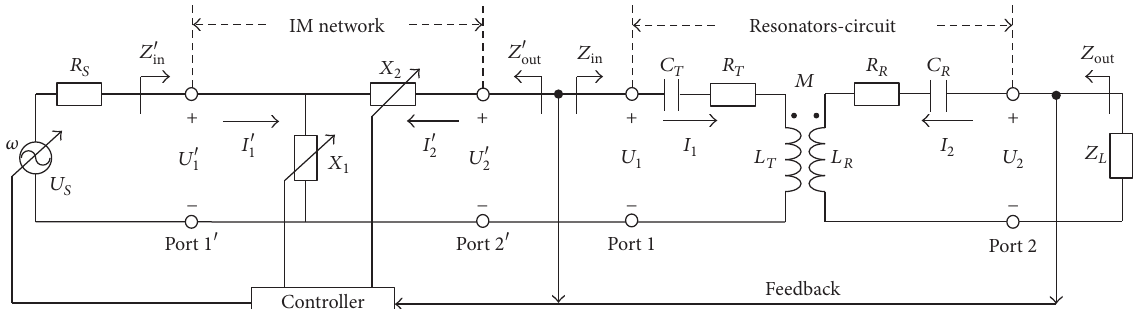
Figure 3: Proposed frequency-tracking and impedance-matching combined WPT